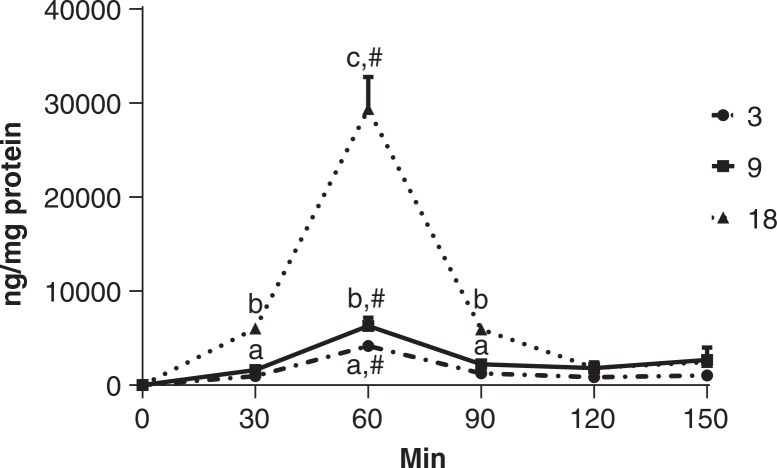
The uptake of quercitrin by Caco-2 cells. Quercitrin at the concentration of 3, 9, or 18 μg/mL is administered to the cells 24 h after being seeded. Vehicle containing no quercitrin was also administered but the data were depicted in the figure because quercitrin was not detected. Quercitrin is quantified using LC-MS in cell lysates at 30, 60, 90, 120, and 150 min post administration. Values are expressed as mean ± SD (n = 3). abcMeans at the same timepoints without sharing the same letter significantly differ (P < 0.05), tested by variance analysis of factorial design, followed by Fisher’s least significant difference (LSD) test with Bonferroni adjustment for multi-comparison. #Mean within the same dose group is significantly different from others at different timepoints (P < 0.05).